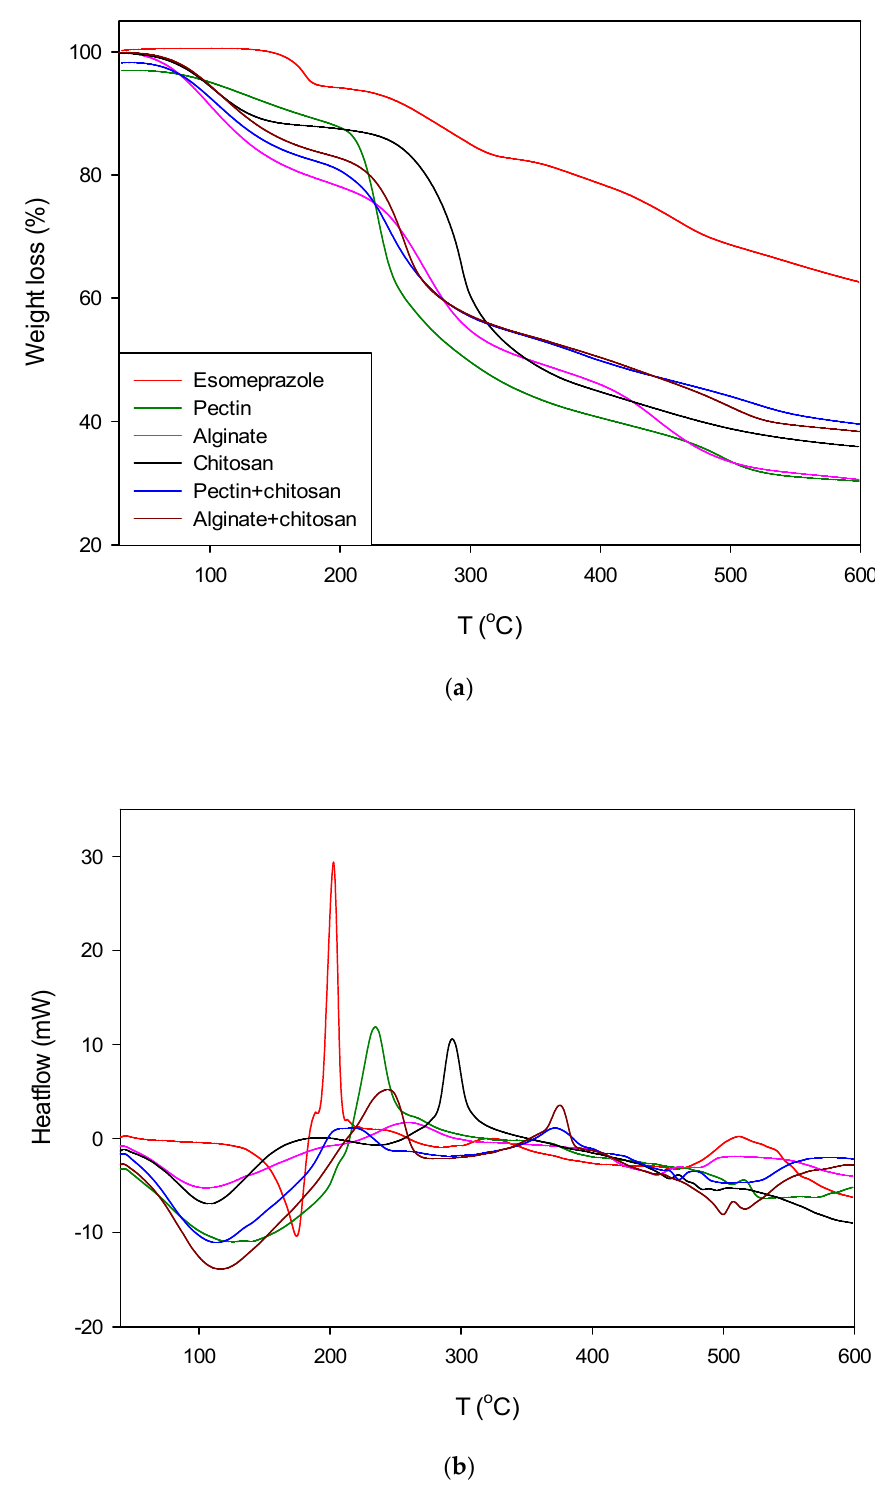
Figure 3. ( a ) TGA curves for esomeprazole and pectin, alginate, chitosan, and their composites impregnated with esomeprazole, ( b ) DSC curves for esomeprazole and pectin, alginate, chitosan, and their composites impregnated with esomeprazole.